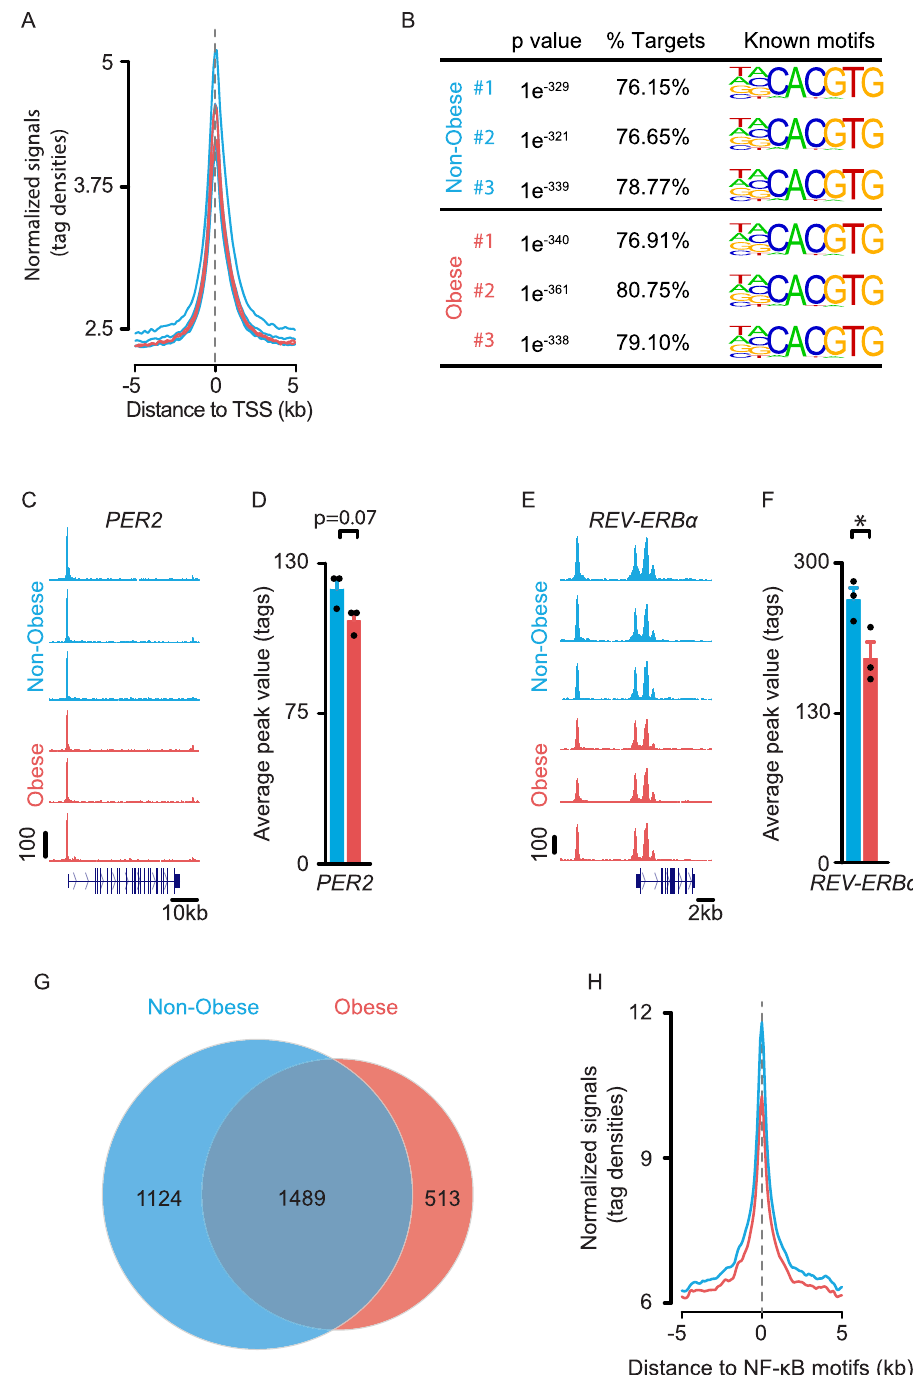
Fig. 5 Obesity repositions BMAL1 binding genome-wide in human adipocyte precursors. A Average plot of BMAL1 ChIP-seq reads on the target gene promoters near TSS in OAPs from non-obese ( n = 3; blue) and obese (Class III) patients ( n = 3; red). B Top known HOMER motifs enriched at BMAL1- binding sites from ChIP-seq analysis in OAPs from non-obese and obese patients. The highest ranking motif for each patient is shown and corresponds to the canonical E-box motifs. Signi fi cant motif enrichment was determined using a cumulative binomial statistical test. C – F University of California at Santa Cruz (UCSC) genome browser images of BMAL1 ChIP-seq tracks at clock repressors and related histograms. UCSC genome browser images of BMAL1 ChIP-seq tracks at PER2 ( C ) and REV-ERB α ( E ). Normalized tag counts are indicated on the Y -axis and maximum track height is the same for all samples (n = 3 subjects/group). The orientation for each gene is indicated below each browser track. D , F Respective histograms depicting the average peak value per condition are also represented. Data are means± SEM, * p < 0.05, by unpaired two-tailed t- test. G VENN diagram depicting the number of BMAL1 peaks and overlap in non-obese and obese OAPs (Raw data in OAPs from 3 patients/ group are provided in Source Data). H Average plot of BMAL1 ChIP-seq reads depicting their distance to NF- κ B consensus motifs on target genes. NF- κ B sites were obtained from UCSC Genome Browser ’ s Factorbook data, which were lifted over from hg38. The normalized signal fi les for each group (average n = 3 subjects/group) were merged to show that BMAL1 binds in close proximity to NF- κ B consensus motifs. See also Supplementary Fig.